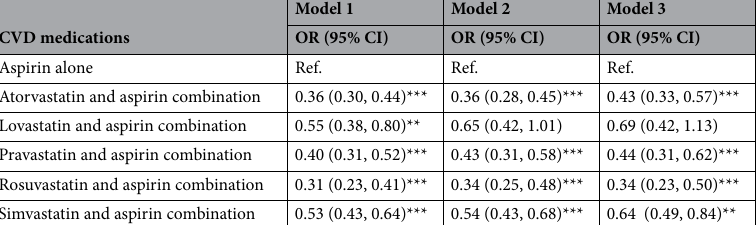
CVD medications